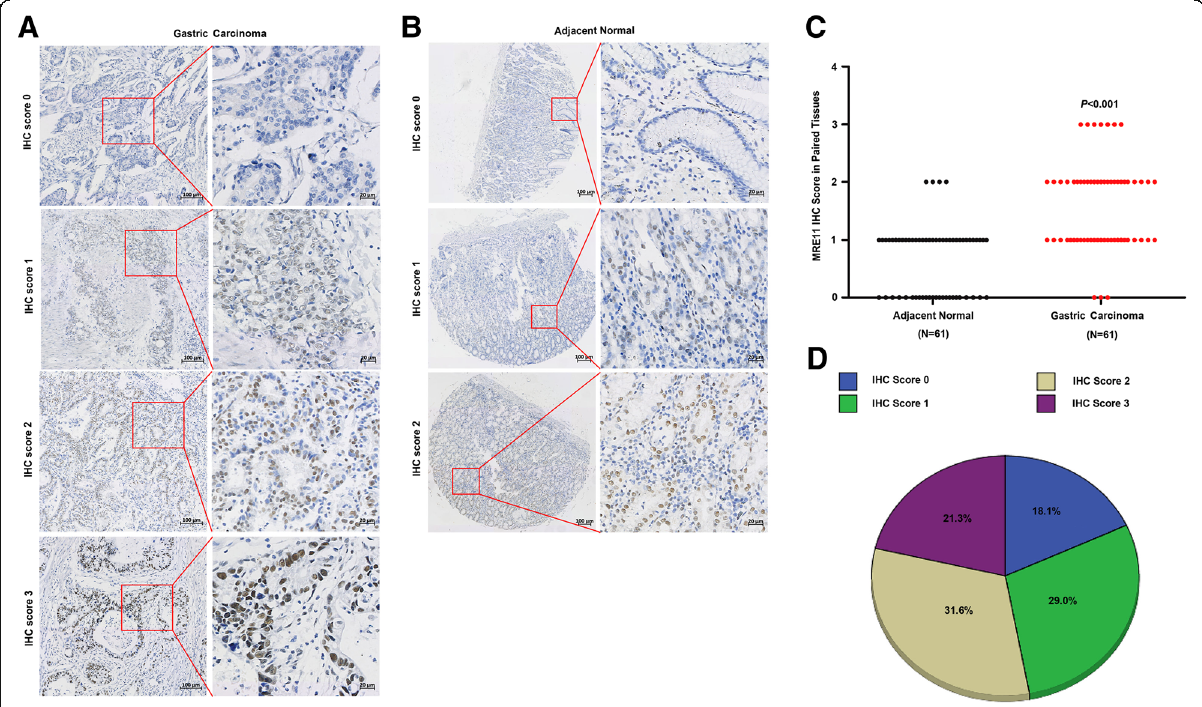
Fig. 2 MRE11 protein expression in GC tissues and adjacent normal tissues. a IHC staining of the MRE11 protein in GC tissues. b IHC staining of the MRE11 protein in adjacent normal tissues. c MRE11 protein expression was higher in GC specimens than in adjacent normal tissues, as indicated by IHC staining. d Percentage of patients with GC according to MRE11 protein expression as indicated by IHC